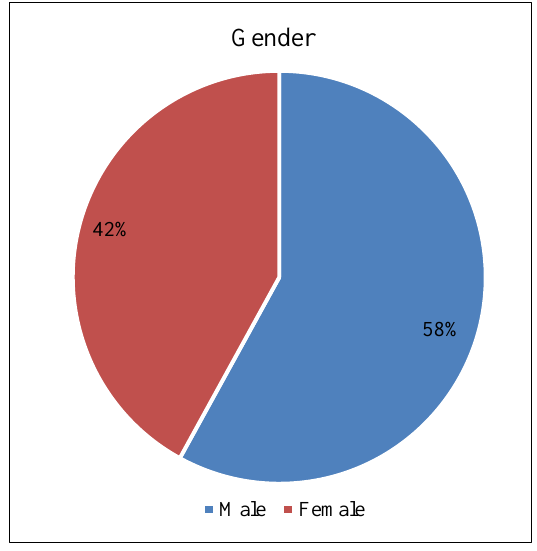
Figure 3. Gender of the participants